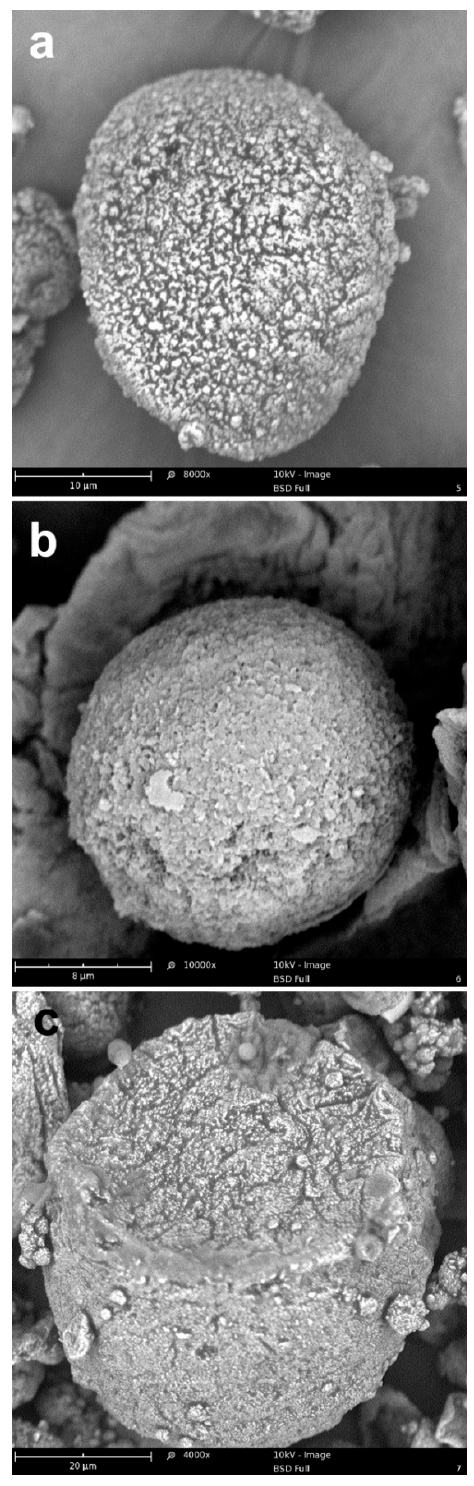
Figure 6. SEM micrographs of B microspheres ( a ), M9b ( b ) and M9g ( c ).